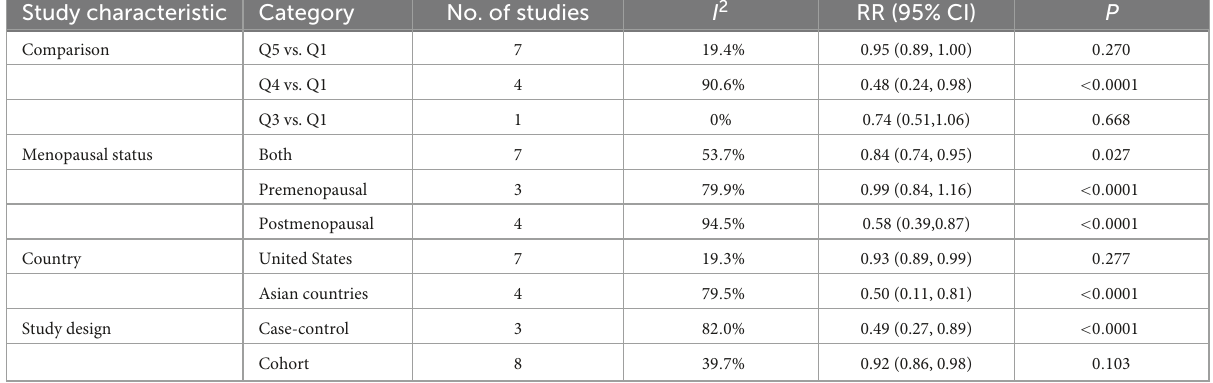
TABLE 2 Subgroup analyses for the association between DASH diet and risk of breast cancer. Study characteristic